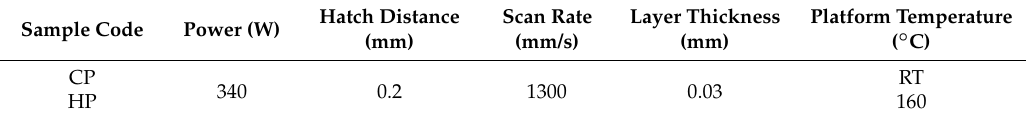
Table 1. Process parameters adopted for the production of the AlSi10Mg samples.